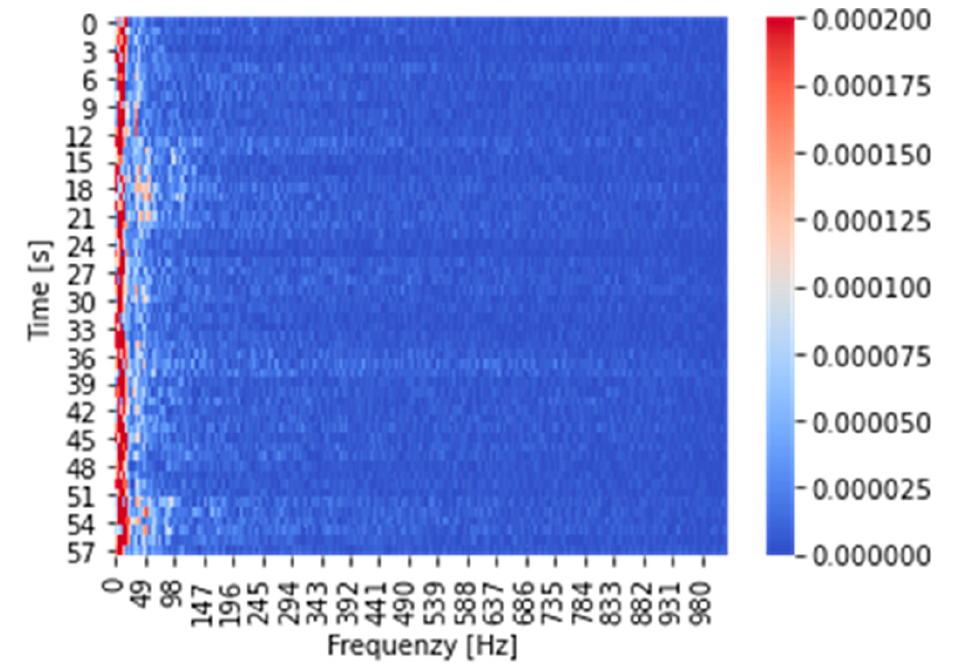
Figure 2. Fast Fourier Transformed vibrometer data over 60 s measurement interval.